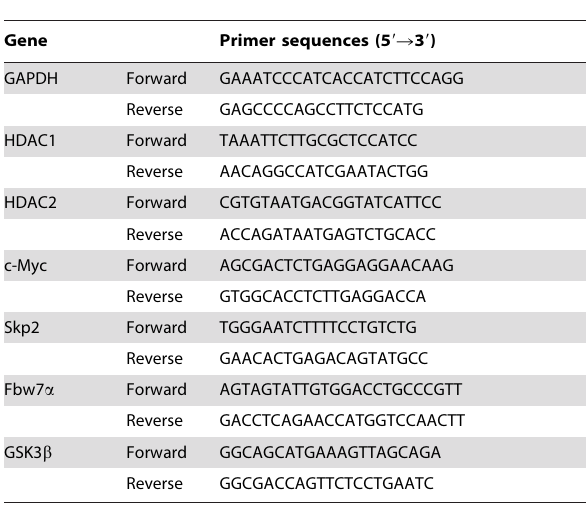
Table 1. Primer sequences for real-time PCRs.